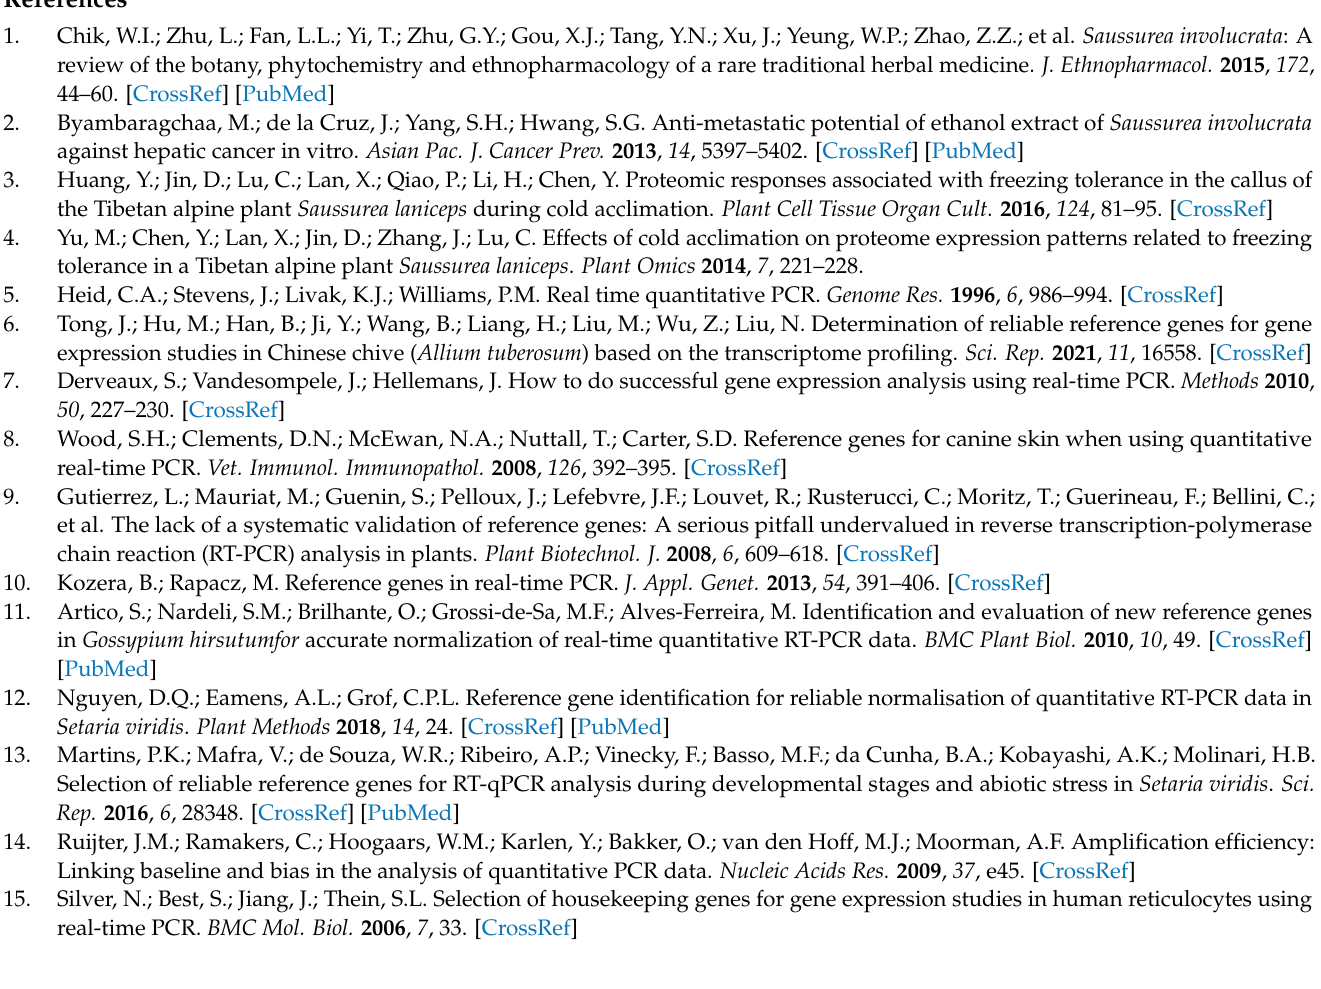
Figure S2: Melting curves for eleven reference genes in Saussurea Laniceps; Table S1: Gene expression stability under multiple conditions ranked by ∆ CT, BestKeeper, NormFinder, geNorm, and RefFinder; Table S2: Raw Ct values of 11 candidate reference genes under different treatments with 3